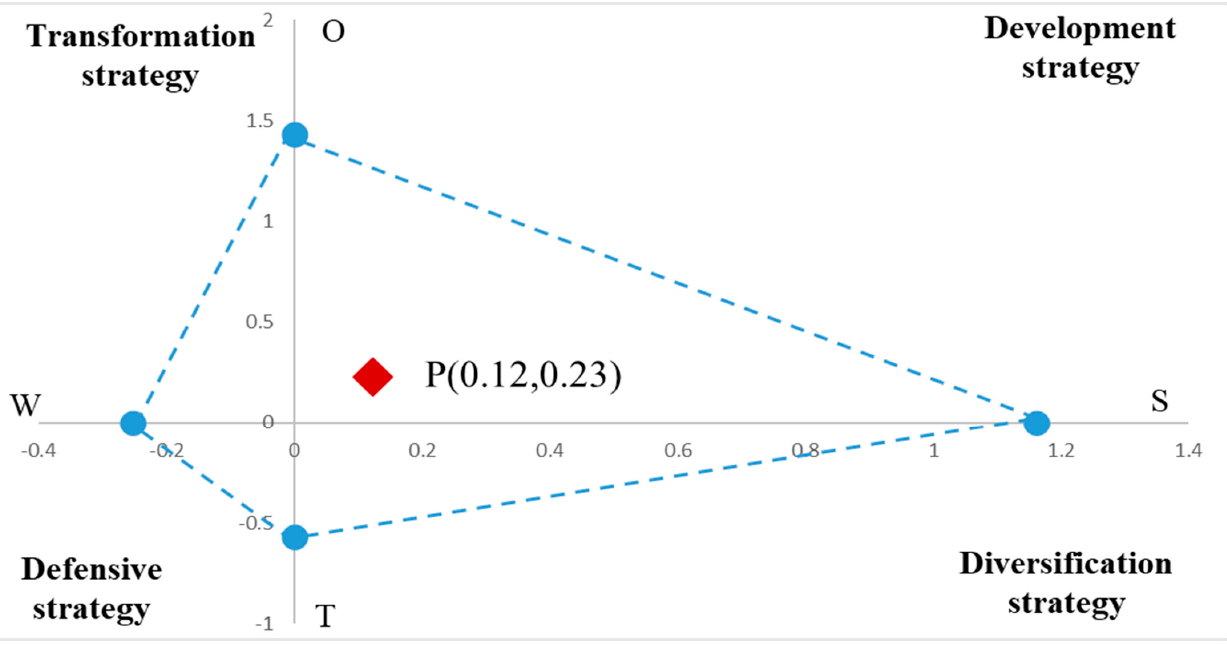
Figure 11. Strategy quadrilateral.